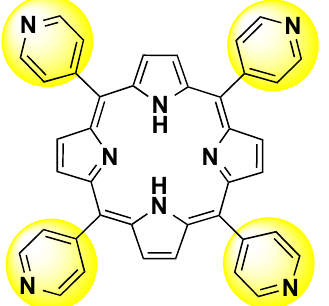
Figure 1. Chemical structure for 5,10,15,20-tetra(pyridine-4-yl)porphyrin.